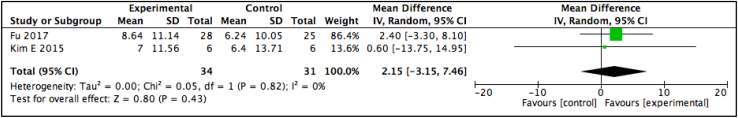
Pooled analysis for the Wolf Motor Function Test in patients with stroke.